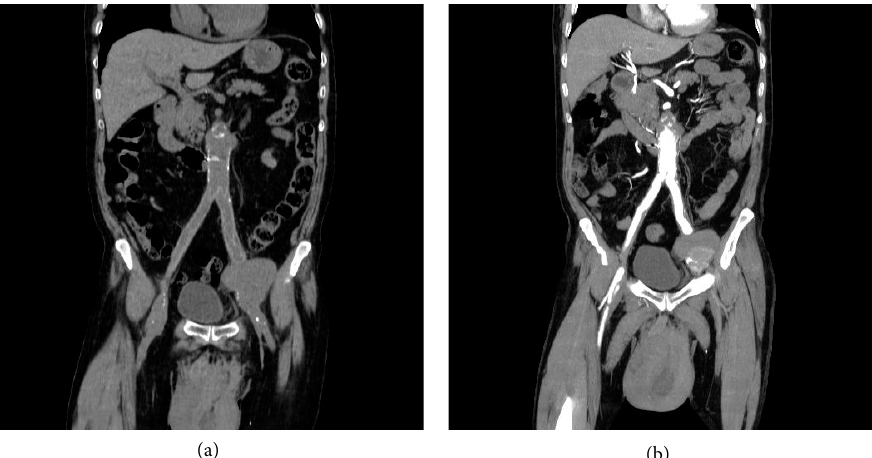
Figure 2: (a) & (b) Coronal MPR images before and after contrast media administration, showing both aortobifemoral graft presence and left anastomotic pseudoaneurysm rupture. Scrotal hematoma is also